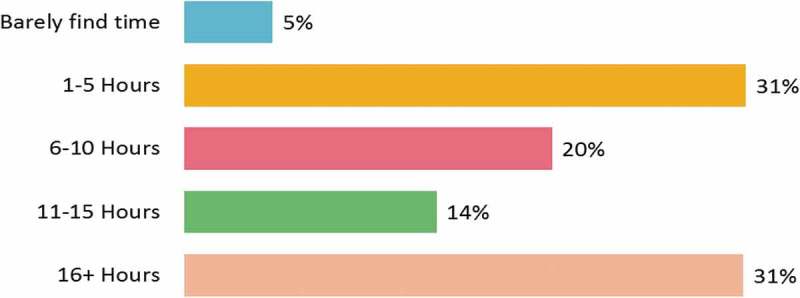
Time spent on all types of medical education activities per month (n = 746).